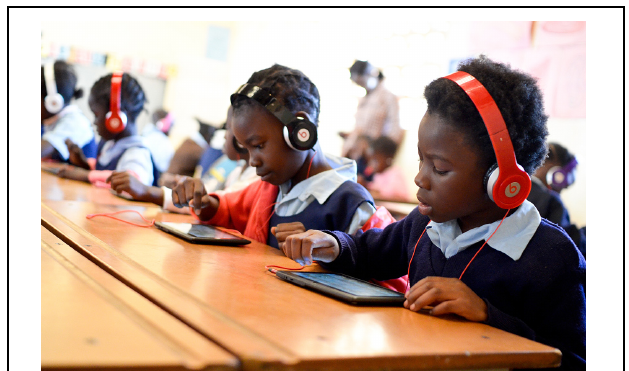
FIGURE 2 | Children playing with GG tablets in Lusaka 2013. Picture credit Karri-Pekka Kauppinen/University of